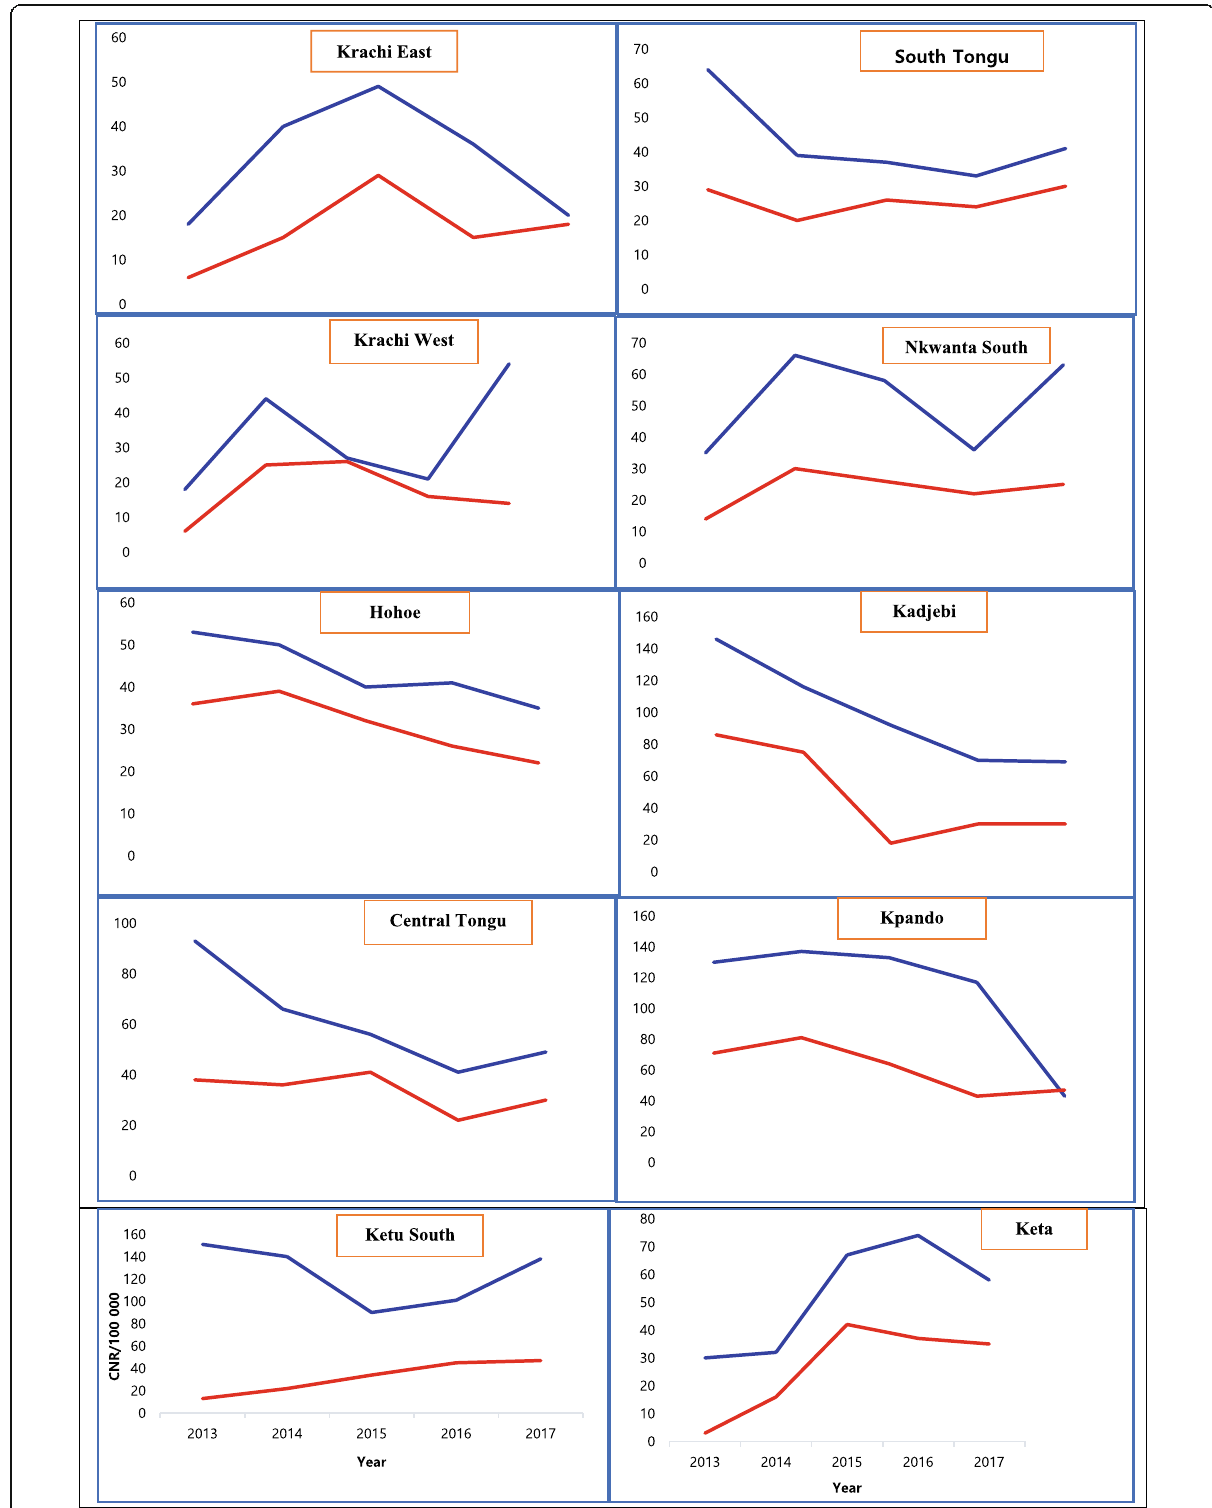
Fig. 3 District Trends in TB case Notification Rate, Volta Region, Ghana, 2013 – 2017. The blue line shows all forms of TB and the red line shows Smear positive pulmonary TB